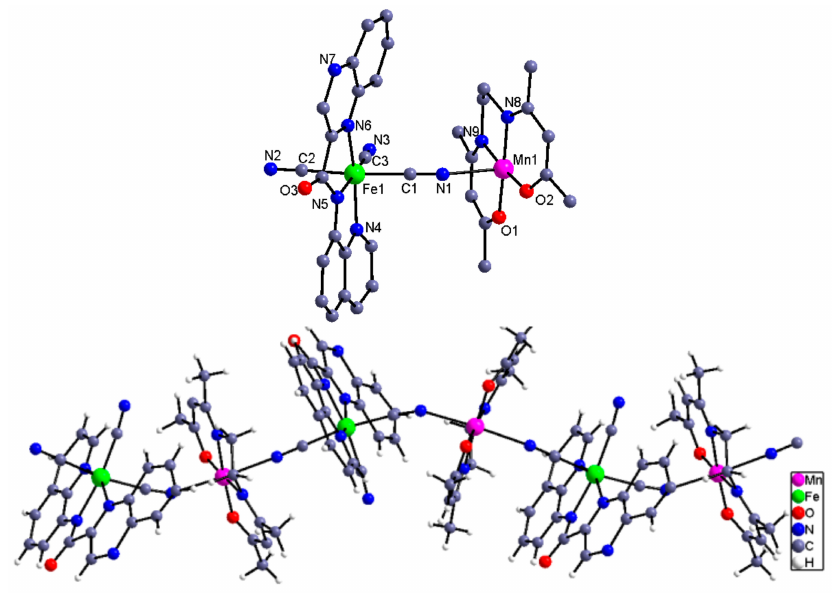
Figure 4. The independent binuclear and 1D structure of complex 4 .